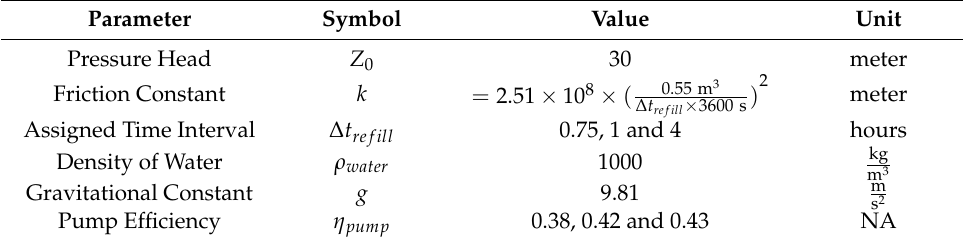
Table 6. Parameters for Equation (12) specifying parameter, symbol used, value and units used. Parameter Symbol Value Unit